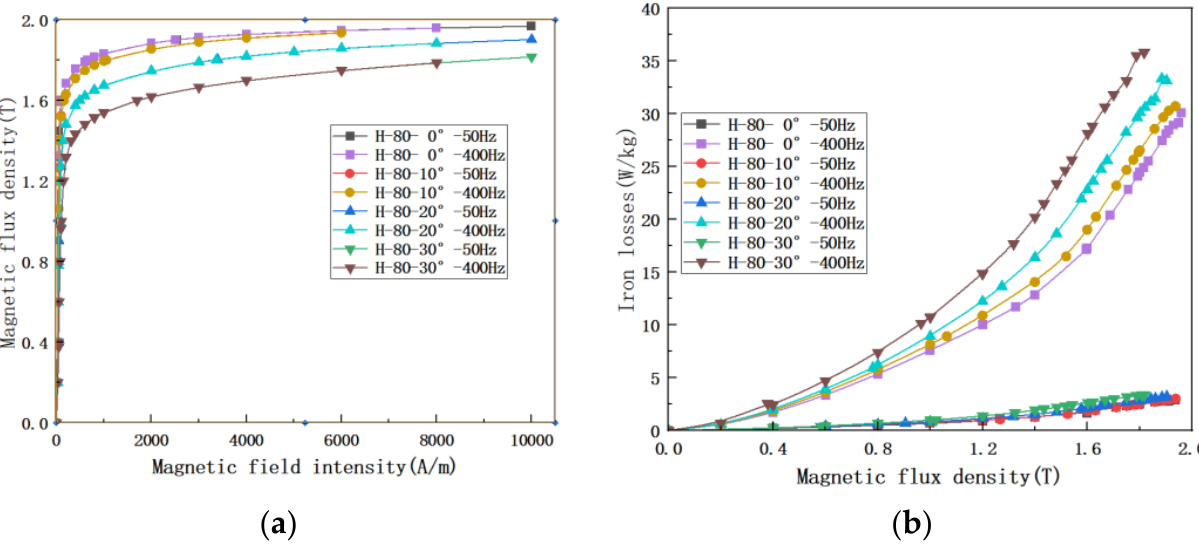
Figure 10. Magnetic characteristics of grain-oriented silicon steel at different angles ( a ) magnetization curves of H-80 material at different angles @400 Hz; ( b ) iron loss curves of H-80 material at different angles @400 Hz.